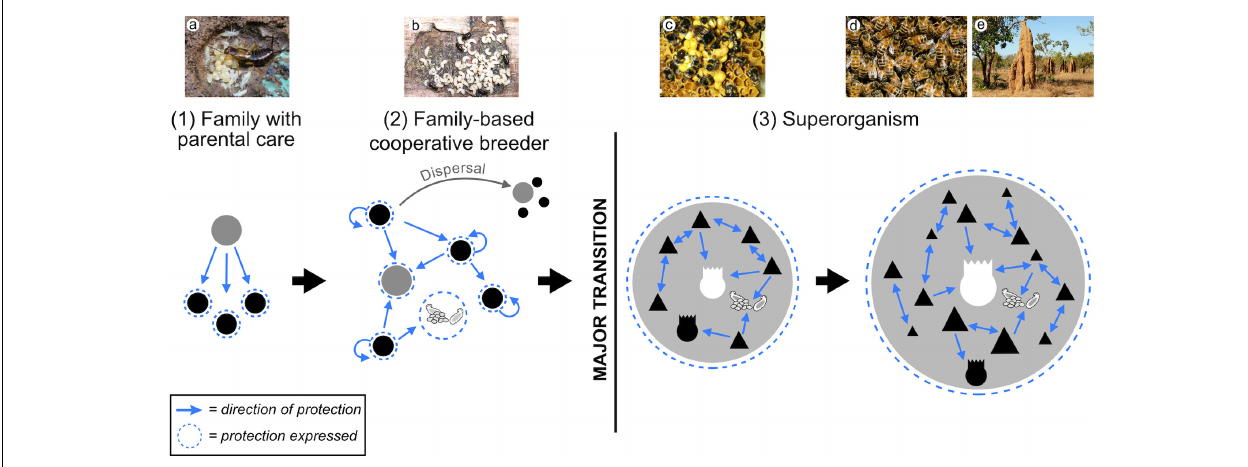
FIGURE 3 | The evolution of superorganism immunity. Superorganisms evolve from subsocial and family based cooperatively breeding ancestors with full-sibling helpers, termed the “subsocial route” to sociality. (1) In insect families [e.g., earwig mother and offspring (a)], extended parental care is primarily administered from parent to offspring to increase the chances of offspring survival and thus parent reproductive success. Both solitary and subsocial insects express many behaviors that appear to have acted as the building blocks upon which social immune systems later evolved. (2) In family based cooperative breeders, some totipotent offspring are retained as helpers at the nest to raise additional siblings. There is considerable variation in insect cooperatively breeding systems, with helpers in some species gaining most of their fitness through independent reproduction, whereas others derive most, if not all, fitness indirectly. Consequently, the evolution of incipient social immune systems in more advanced societies may be observed (i.e., the single piece nesting lower termites). However, in less complex societies where most/all individuals readily disperse [e.g., Xyleborinus ambrosia beetles (b)], social disease defenses are predicted to be less advanced. Hence, we expect social disease protection of individuals, but not a true social immune system. (3) In contrast, obligate worker altruism and the subsequent “transfer of fitness” to the colony-level selects for the evolution of a true immune system in superorganisms. This superorganism immunity is a higher-level adaptation that maximizes superorganism fitness. We predict significant variation in immune system protection that reflects the degree of “individuation” found among superorganisms, i.e., from less advanced [e.g., bumblebees (c)] to more advanced linages [e.g., honeybees (d) and fungus-growing termites (e)]. Photos by: (a) Tom Oates, 2010, available at Wikimedia Commons (CC BY-SA 3.0: https://creativecommons.org/licenses/by-sa/3.0/deed.en), (b) Peter Biedermann, (c) Victoria Blanchard, (d,e)